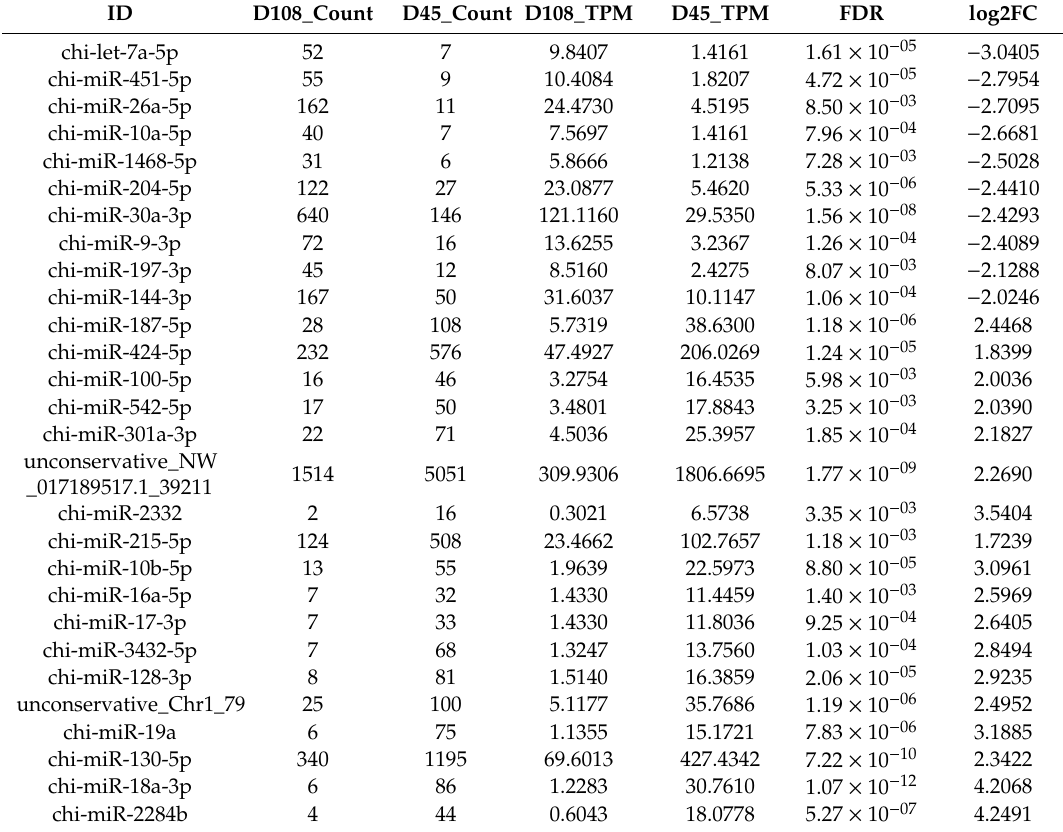
Table 1. Statistics of di ff erentially expressed microRNAs